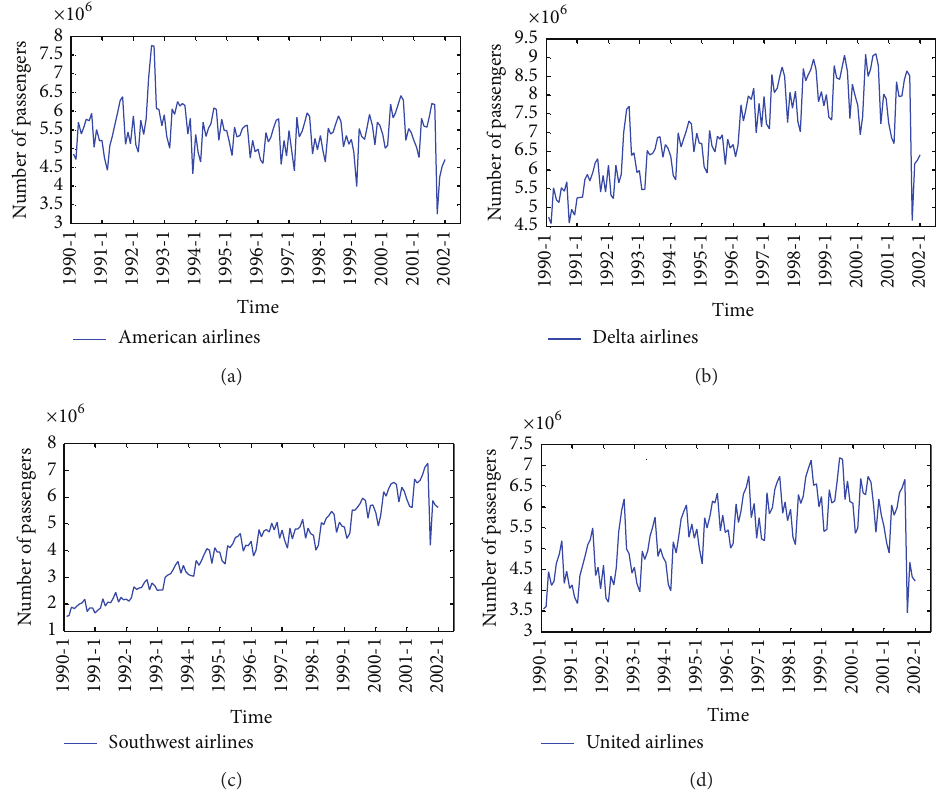
Figure 2: (a) American Airlines data. (b) Delta Air Lines data. (c) Southwest Airlines data. (d) United Airlines data.